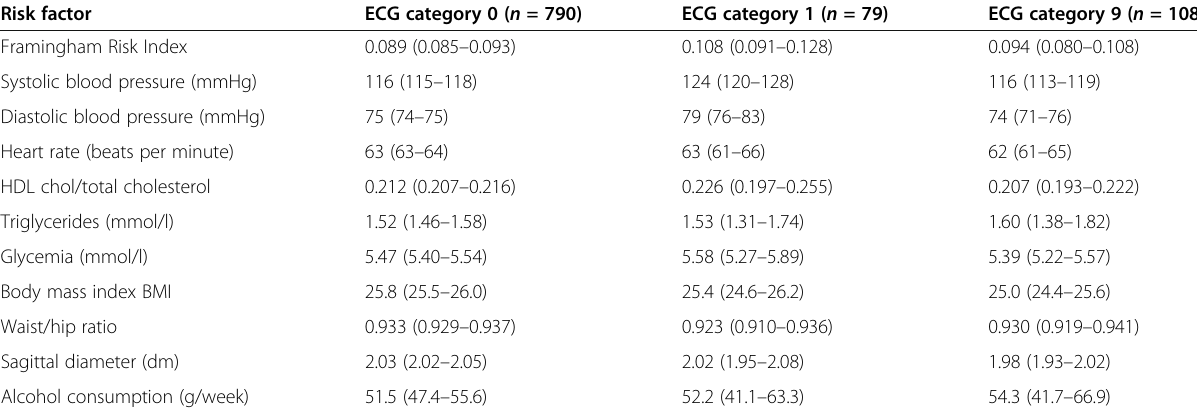
Table 4 Estimated means with 95% confidence intervals in brackets for continuous baseline risk factors by ECG